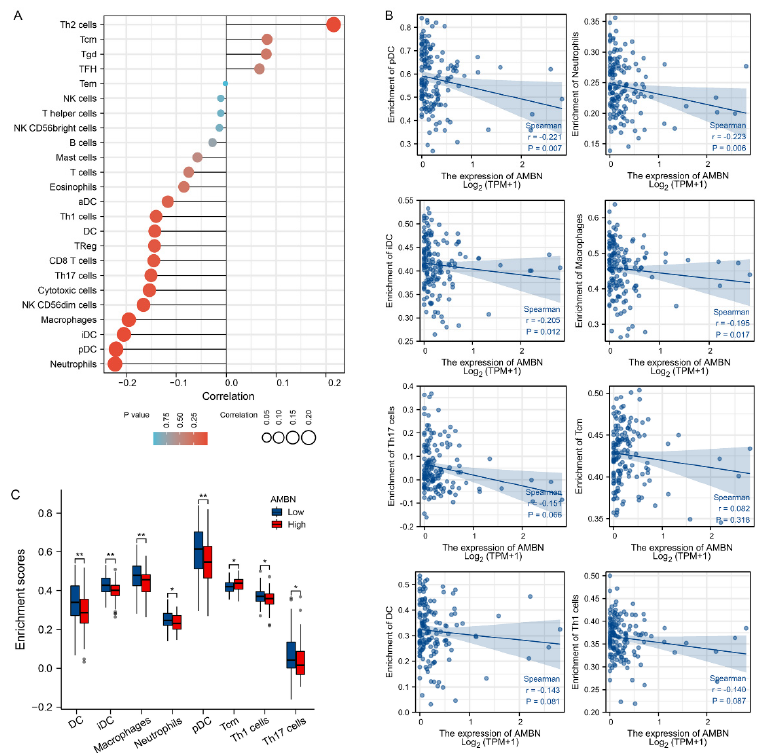
Figure 3. Correlation analysis of AMBN mRNA expression and immune infiltration in TGCT ( A , B ) Correlation of AMBN mRNA expression in TGCT with the level of immune cell infiltration. ( C ) Analysis of the differences between AMBN high and AMBN low expression in different TGCT immune infiltrating cells. (*, p < 0.05; **, p < 0.01)